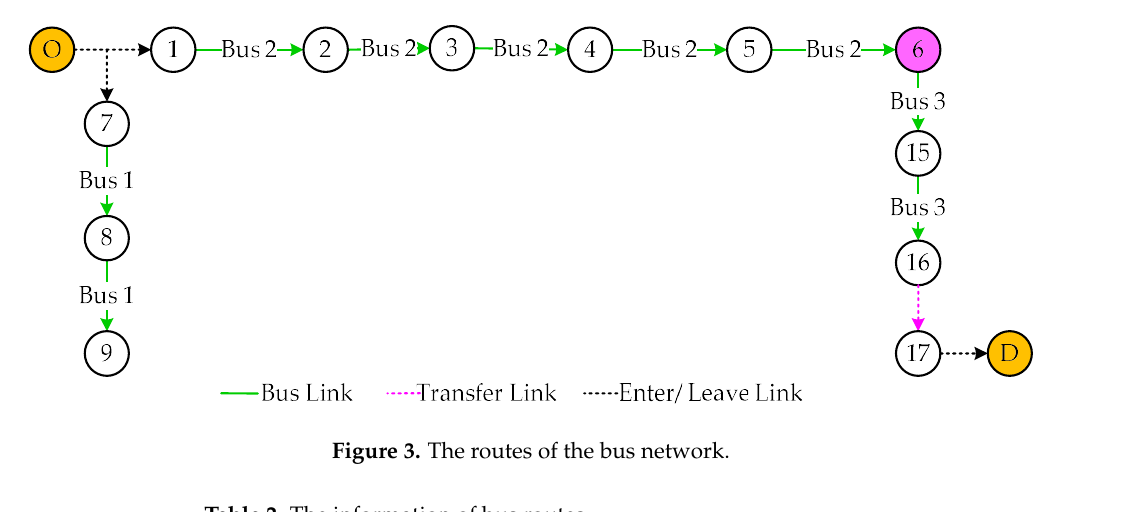
Figure 3. The routes of the bus network.